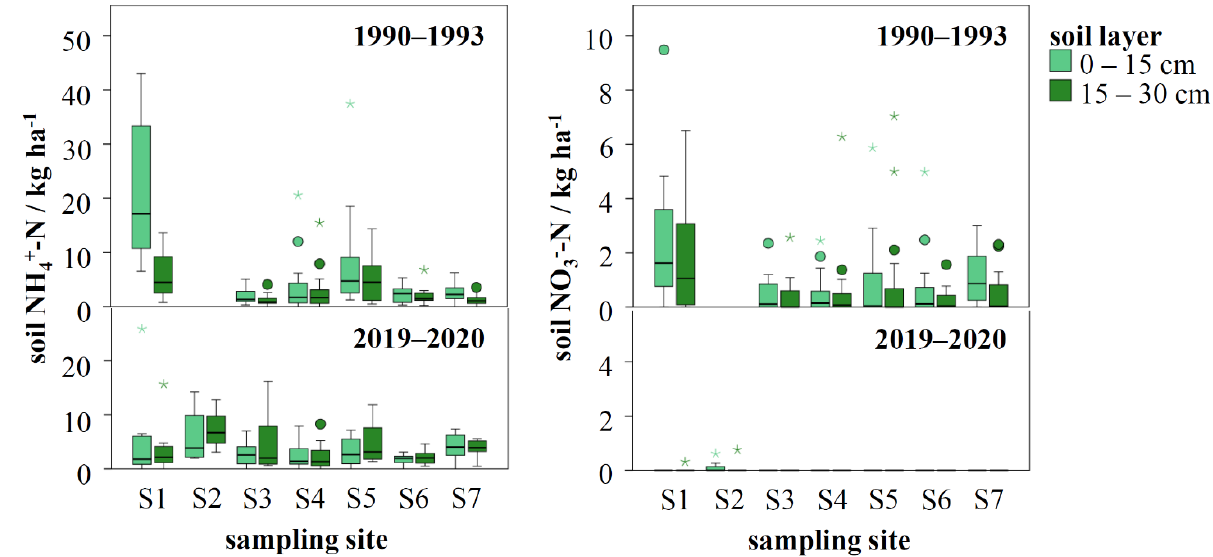
Figure 2. Boxplots of soil NH 4+ -N content (left) and NO 3- -N content (right) during the initial examination in 1990–1993 (Gebhardt & Knabke 1994) and during the follow-up examination in 2019–2020. Gradient from S1 = driest to S7 = wettest site; ° mild outliers, * extreme